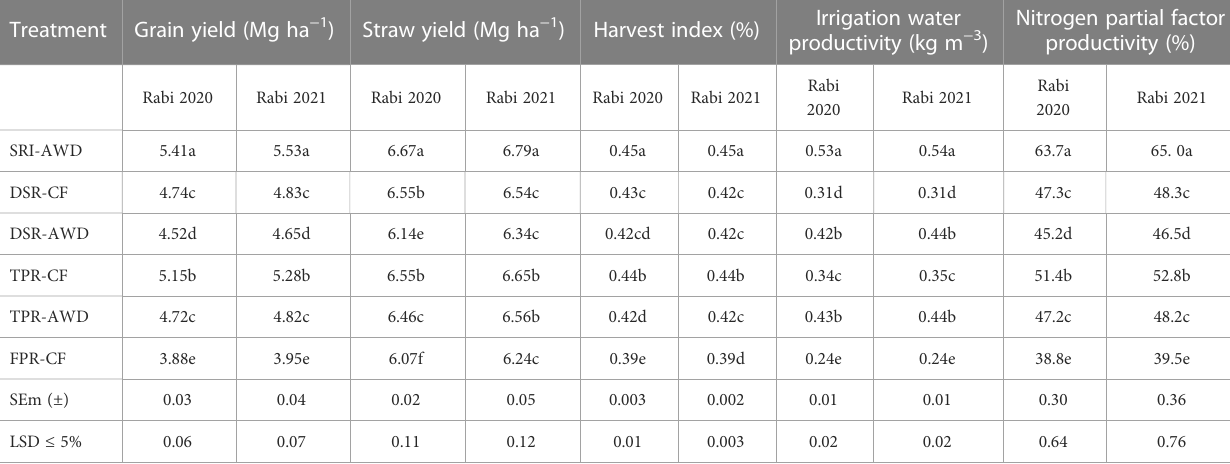
TABLE 3 Yield, irrigation water productivity, and nitrogen partial factor productivity of rice crop as in fl uenced by different rice production techniques.